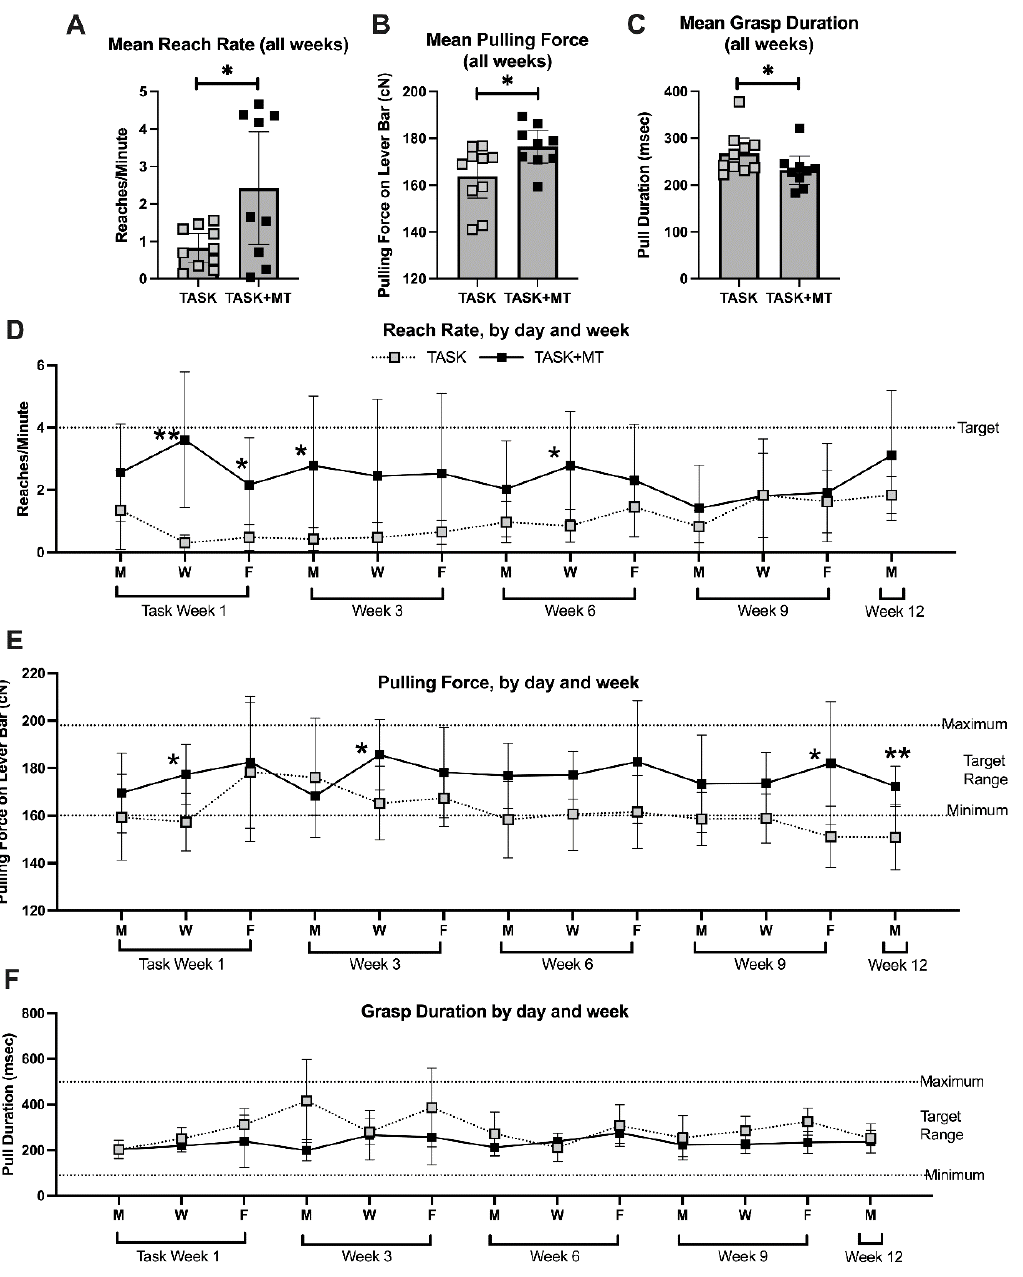
Figure 6. Voluntary task outcomes. Data are shown only for rats performing the task immediately before the time of tissue collection (TASK and TASK+MT). ( A ) Mean reach rate (mean reaches per minute) across weeks. ( B ) Mean pulling force on the lever bar across weeks. ( C ) Mean grasp duration (mean time rat spent holding the lever bar) across weeks. ( D – F ) Mean reach rate, mean pulling force, and mean grasp duration, respectively, shown for selected days (the four sessions of each day were averaged) and weeks (1, 3, 6, 9, and 12). Abbreviations: 12-week TASK rats (TASK); TASK rats that simultaneously received manual therapy for 12 weeks (TASK+MT). Mean ± 95% confidence intervals (CIs) shown. * and **: p < 0.05 and p < 0.01, respectively, compared to TASK group.